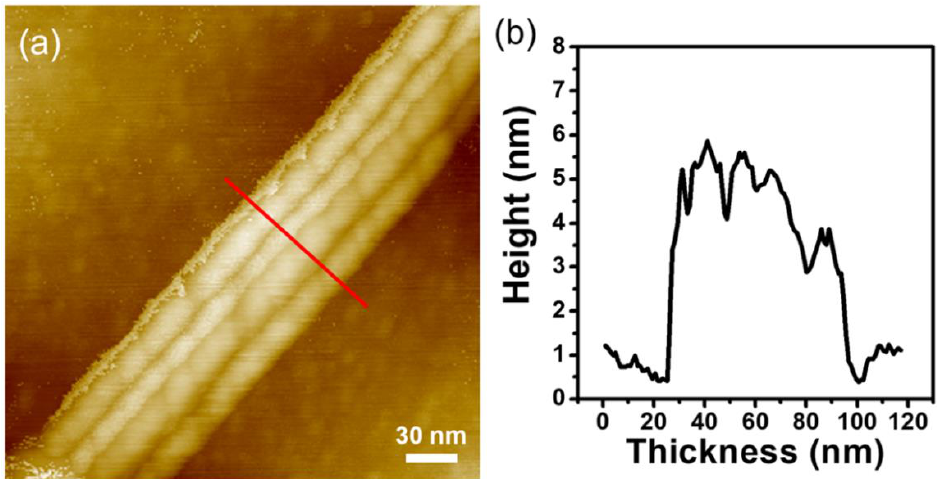
Figure 2. ( a ) Atomic force microscopy (AFM) image of the 1D V 2 Se 9 flake on 300 nm SiO 2 /Si substrate. ( b ) Line-profile of a V 2 Se 9 flake as marked in Figure 2a.